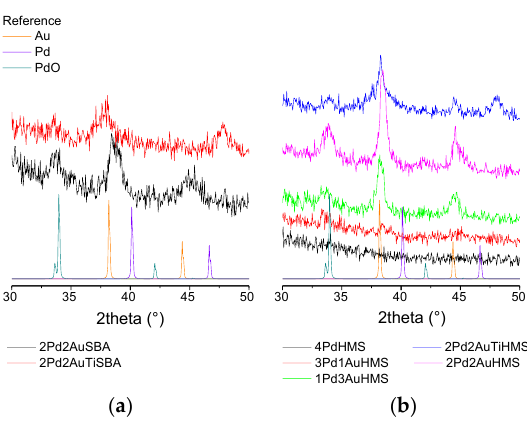
Figure 5. Wide angle XRD of Pd-Au supported on SBA ( a ) and HMS ( b ) as is or Ti-doped.